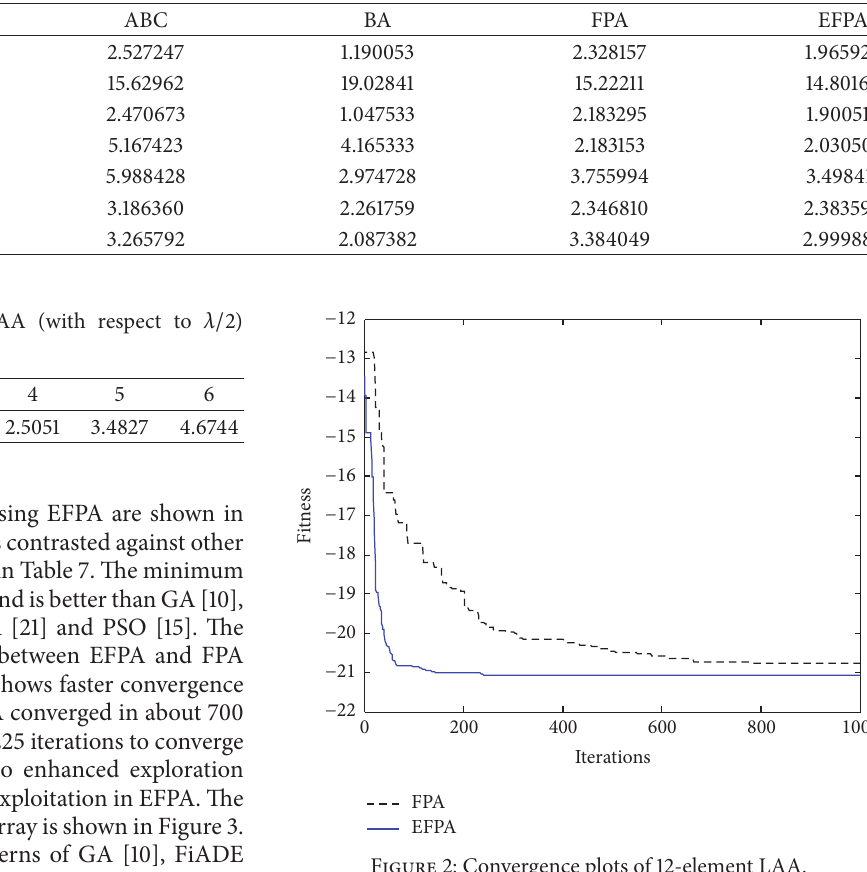
Figure 2: Convergence plots of 12-element LAA.